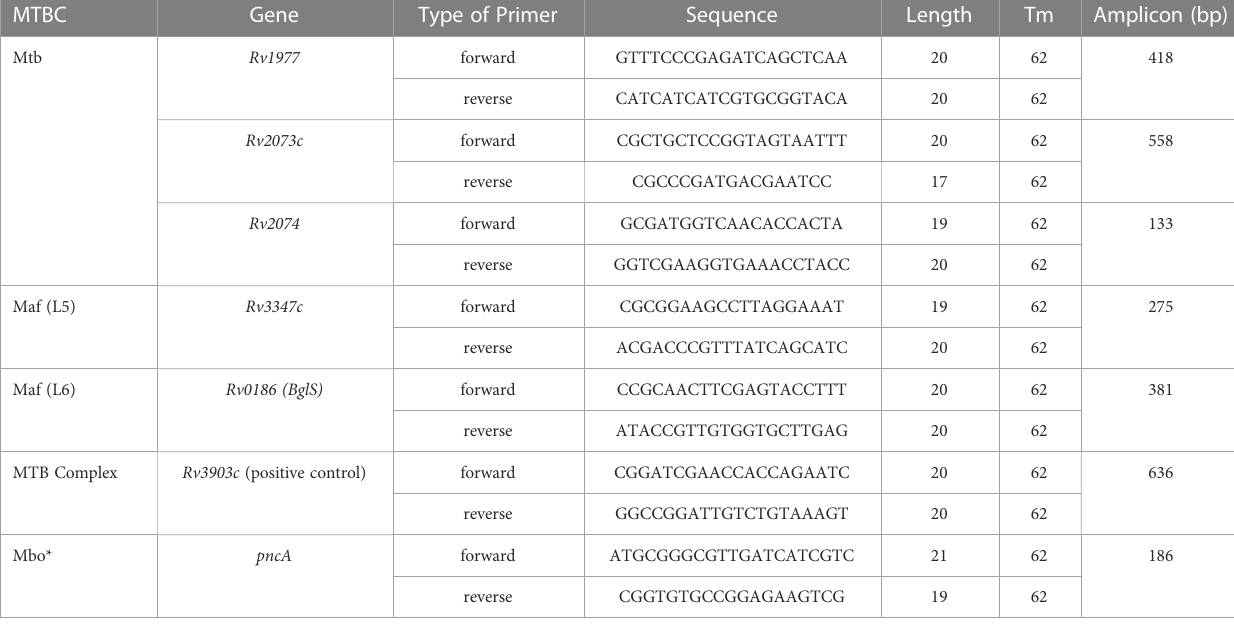
TABLE 1 MTBC lineage-speci fi c genes and primer sequences.